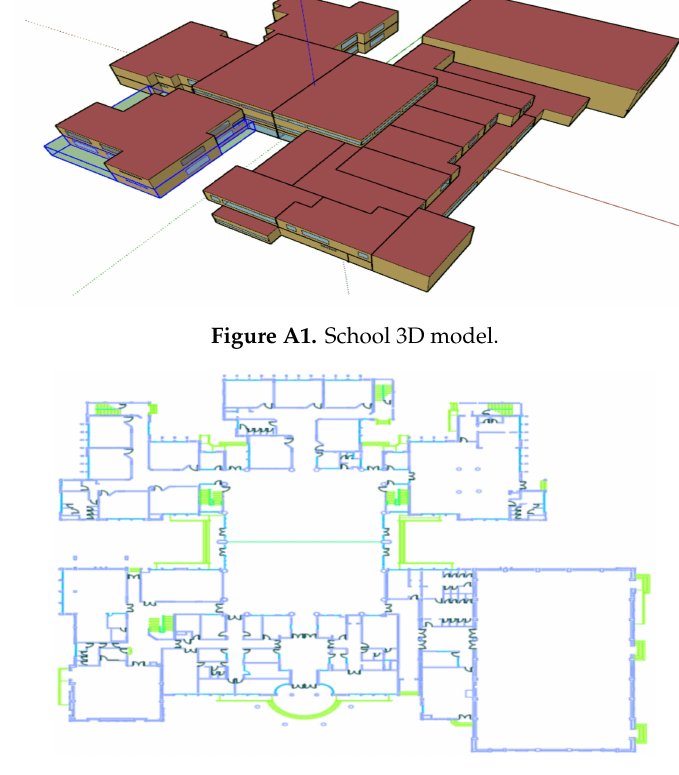
Figure A2. School ground